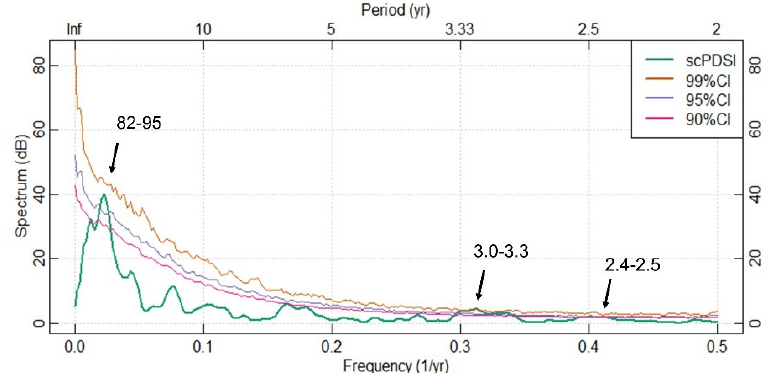
Figure 6. Spatial correlations between the PDSI reconstruction and ( A ) June mean precipitation and ( B ) actual PDSI from the Climate Research Unit, CRU TS4.02 data (1965–2016) ( p < 0.01). Atmosphere 2020 , 11 , x FOR PEER REVIEW